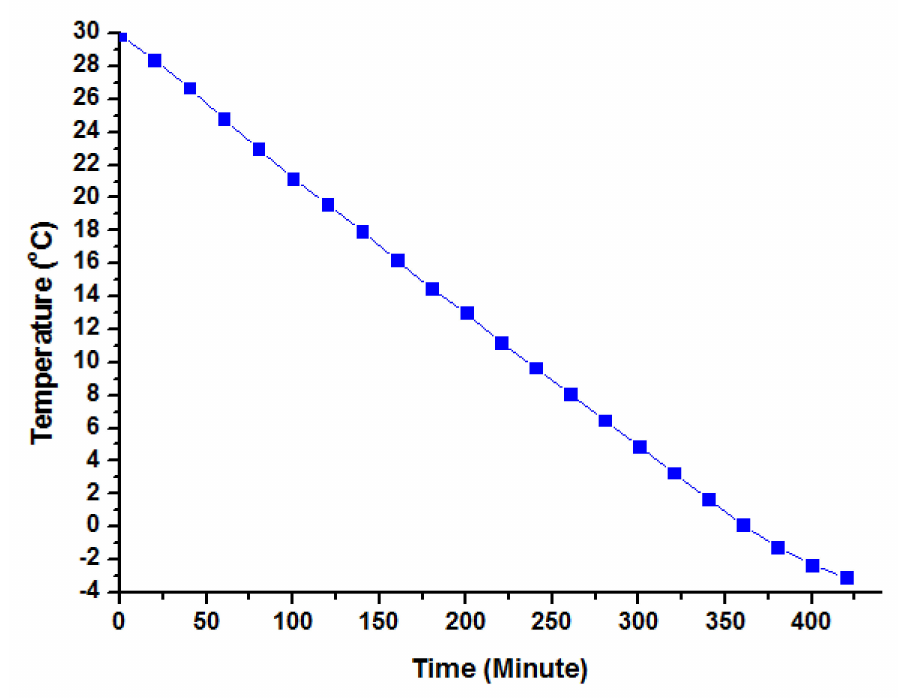
Figure 10. Changes in cold storage material temperature during charging